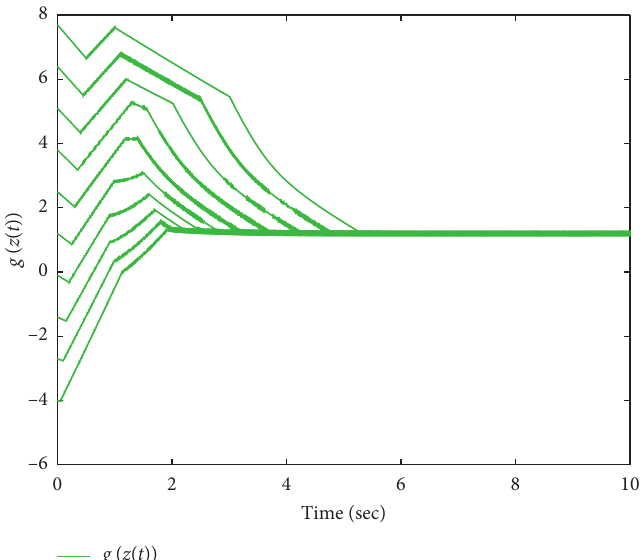
Figure 2: g ( ω ( t )) with ten arbitrary initial states for Example 1.